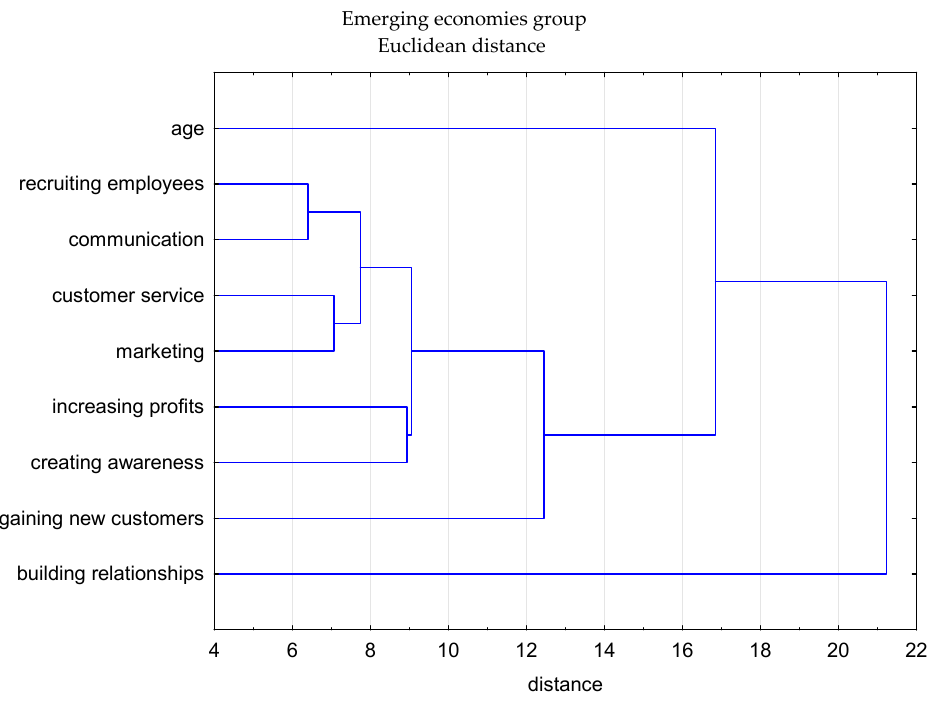
Figure 10. Hierarchical agglomeration for the developed economies group according to Facebook purposes of usage.